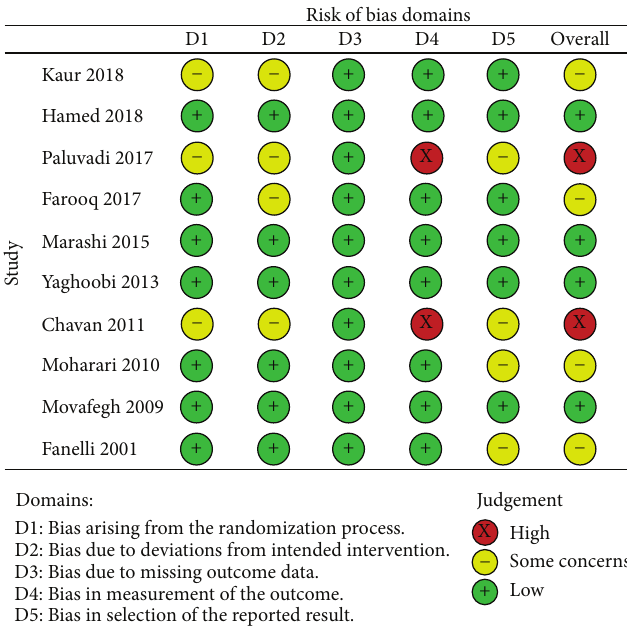
Figure 2: Risk of bias plot for the included